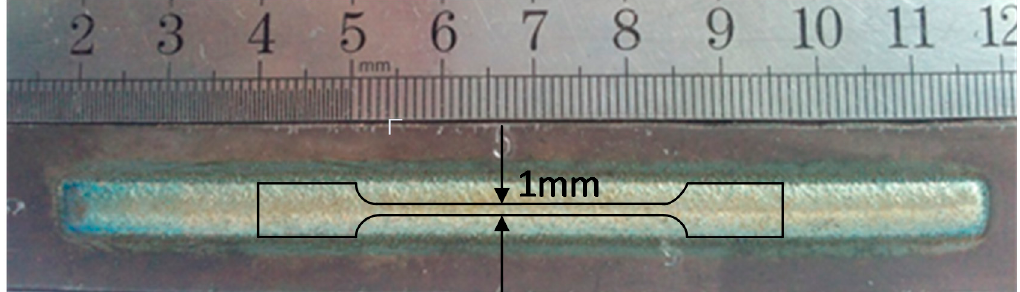
Figure 1. The appearance of the coating and the tensile test specimen.